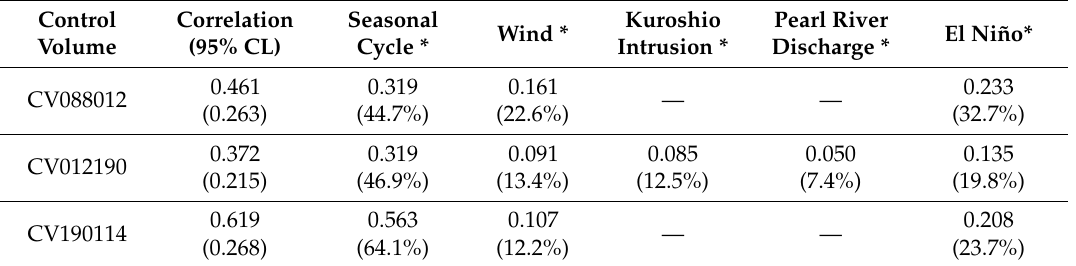
Figure 10. Comparisons between altimeter-derived and reconstructed full cross-shelf volume transports near Dongsha Islands (CV088012), off the Pearl River Estuary (CV012190), and to the northeast of Hainan Island (CV190114). Numbers of control volume, correlation coefficients (95% CL), and RMSDs are shown in the upper left corner of each panel. Table 2. Results of reconstructed cross-shelf volume transports in the NSCS.